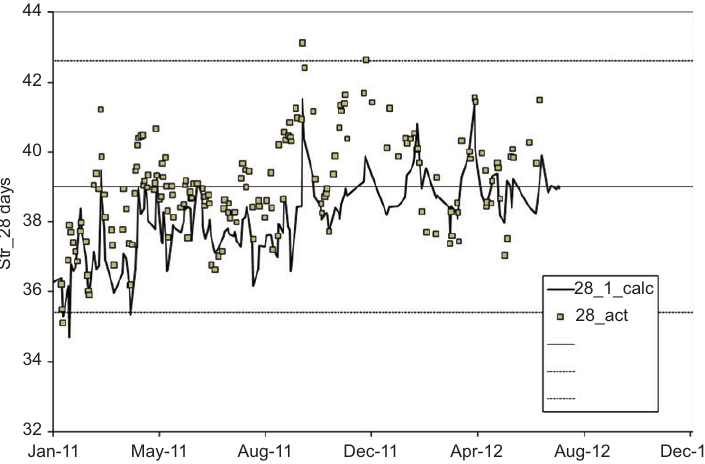
Figure 13 MHM application for CEM BM 32.5 N.